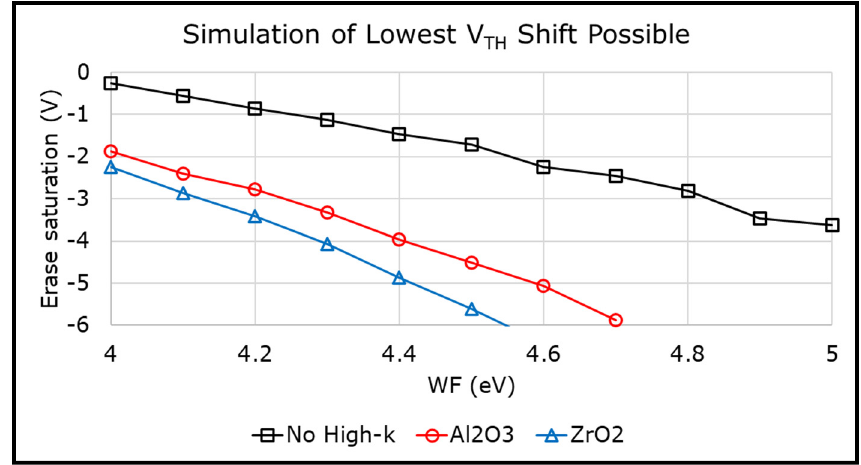
Figure 1. Simulations of erase saturation levels in a memory stack without high-k liner, or with 2 nm Al 2 O 3 or ZrO 2 . Addition of a high-k liner shows more benefit than (work function) WF.